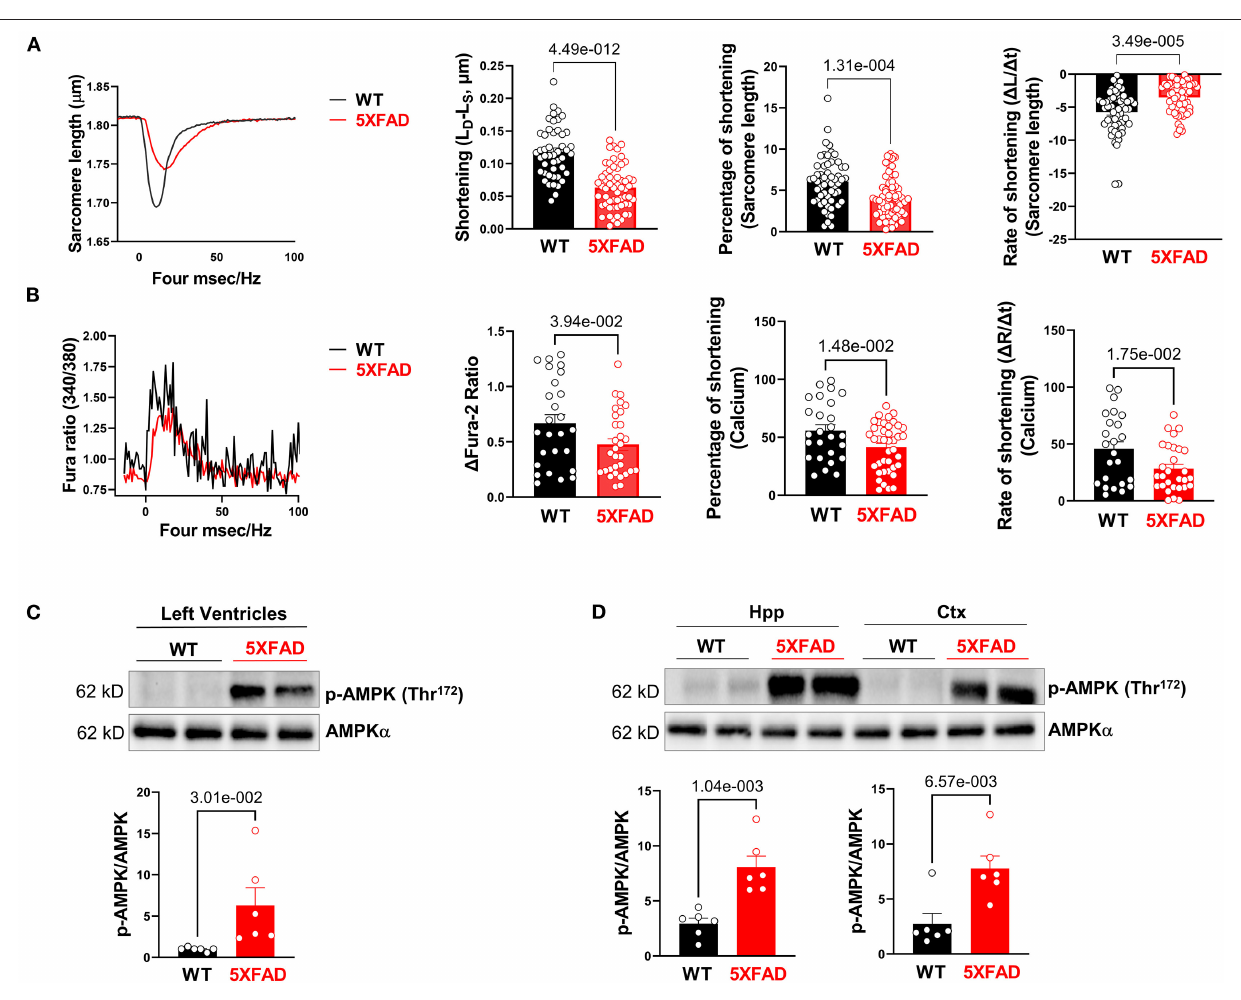
FIGURE 2 | Cardiomyocytes of 5XFAD mice exhibited impaired extend and rate of contraction associated with decreased calcium influx. (A) The contractile properties of isolated cardiomyocytes from 5XFAD (6 months) and WT (6 months) hearts. Biological replicates N = 6 for each group. P -value determined by two-tailed students t -test. (B) The transient calcium signal response of the isolated cardiomyocytes from 5XFAD (6 months) and WT (6 months) hearts. Biological replicates N = 6 for each group. P -value determined by two-tailed students t- test. (C) Immunoblotting showed the phosphorylation of AMPK at Threonine 172 in left ventricles from 5XFAD (6 months) and WT (6 months) hearts. Biological replicates N = 6 for each group. P -value determined by two-tailed students t -test. (D) Immunoblotting showed the phosphorylation of AMPK at Threonine 172 in the hippocampus and cortex from 5XFAD (6 months) and WT (6 months). Biological replicates N = 6 for each group. P -value determined by two-tailed students t-